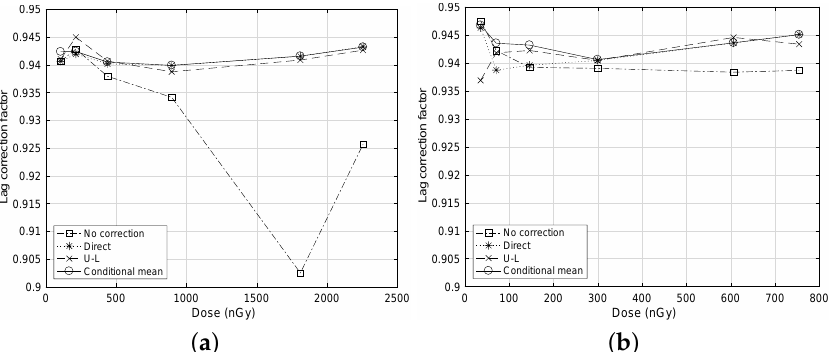
Figure 1. Comparisons of the LCF measurements for the different NTG corrections. The LCF values are calculated from r MA of Equation (3) derived in the correlation method [21] for MA( L ). A sequence has N = 128 images and L = N − 1. ( a ) Frame rate of 10fps; ( b ) Frame rate of 30fps.